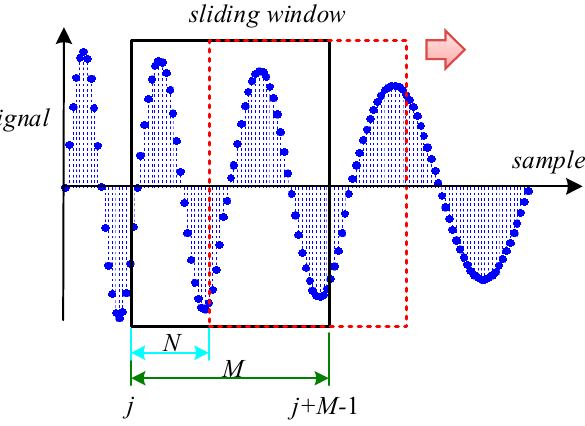
Figure 5. The BCZT TF domain analysis method.